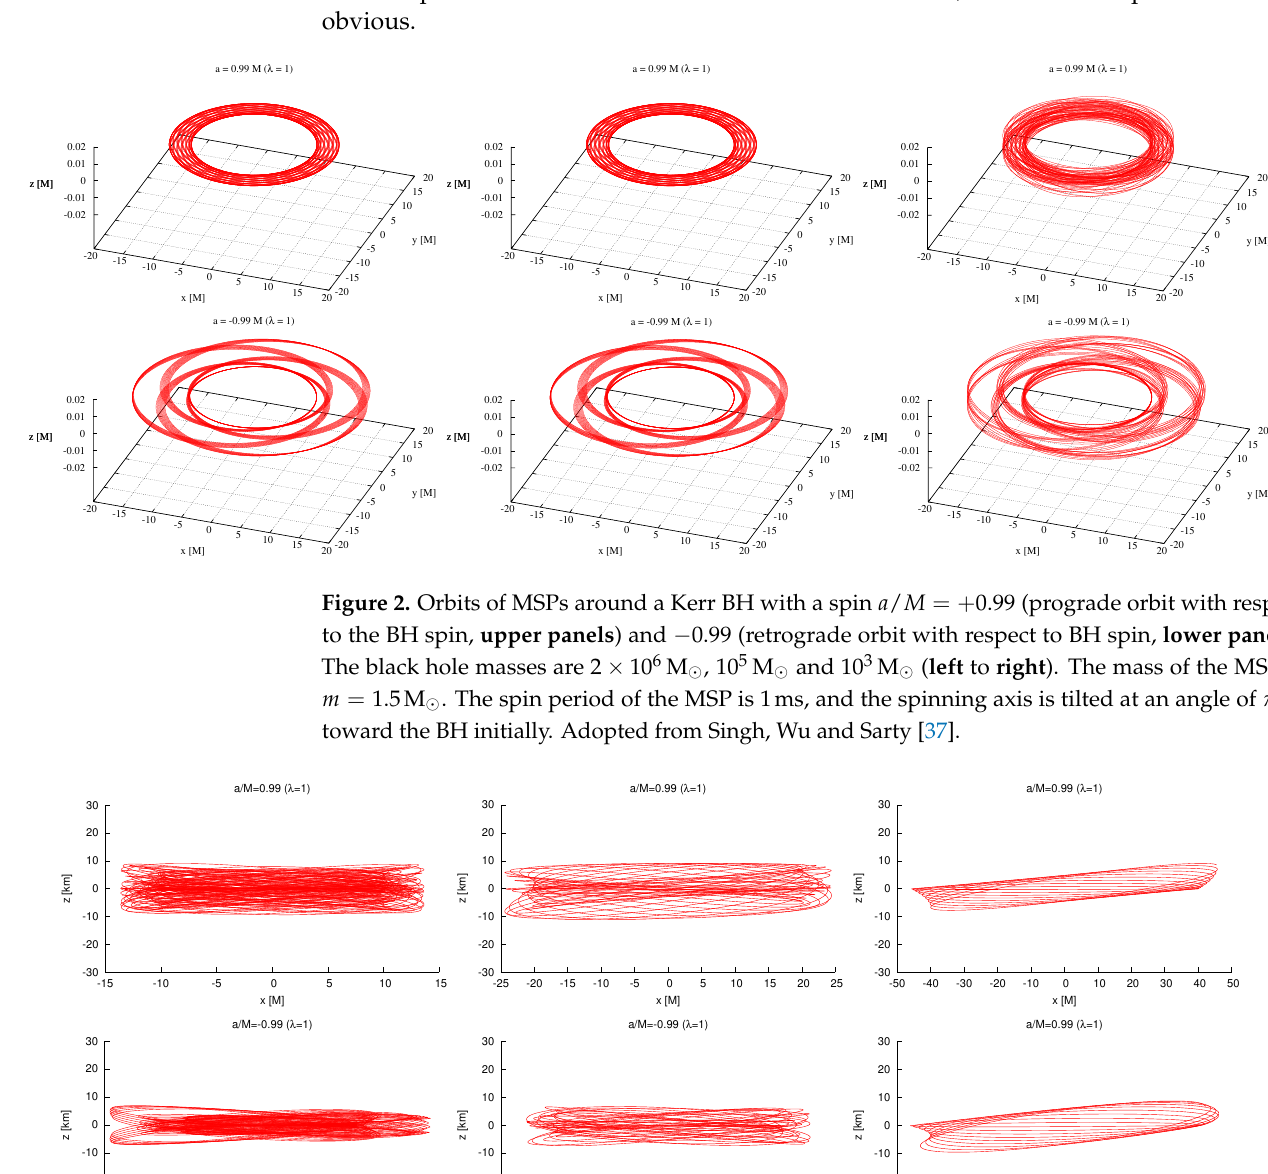
As shown, the orbits are non-circular and not close. They do not lie on a plane. The orbits appear to show more complex patterns when for larger m / M ratios. Moreover, orbits that are retrograde with respect to the BH spin, ( a / M = 0.99) show stronger − deviations from circular motion than orbits that are prograde with respect to the BH spin ( a / M = + 0.99). The MSP’s spin would precess and nutate when the MSP revolves around a black hole. Figure 4 shows the precession and nutation of the MSP’s spin. The spin precession and nutation depend on the strength of the spin–curvature coupling and hence on the separation between the MSP and the BH. However, the trend of dependence is not obvious.